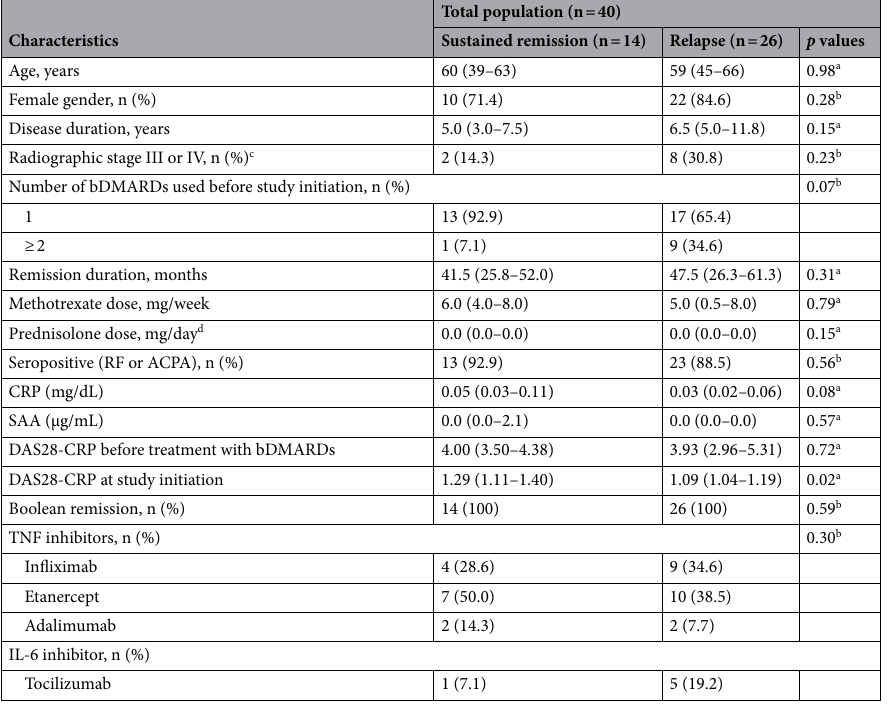
Table 1. Patients demographics. Values are presented as median (inter-quartile range; IQR) unless otherwise specified. a Mann–Whitney’s U test. b Fisher’s exact probability test. c Steinbrocker stage definition 35 . d None of the patients in the sustained remission group was taking prednisolone, and 4 in the relapse group were taking prednisolone at 1 mg in one, 2 mg in two and 3 mg in one at the study initiation. The amount of prednisolone was unchanged throughout the study period. Statistical analysis was performed using EZR 31